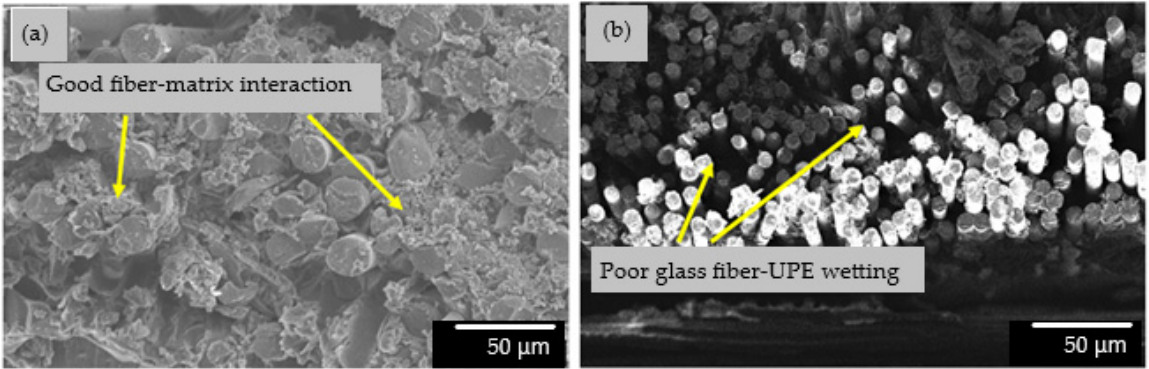
Figure 10. SEM micrographs KBF-treated MMA-esterification/GF hybrid composite at ×100 magnification. ( a ) Hybrid com- posite 20% KBF/10% GF content ( b ) hybrid composite with 30% KBF/10% GF content .